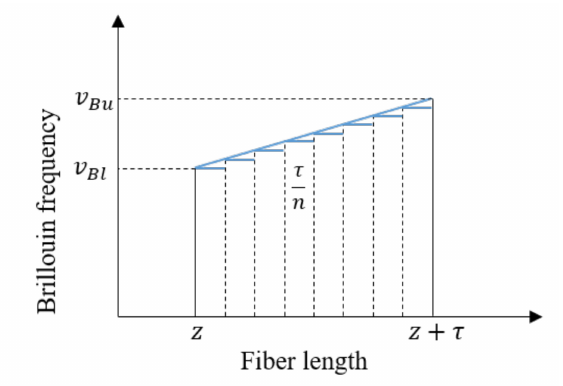
Figure 3. Brillouin frequency of optical fiber with linearly distributed strain field.